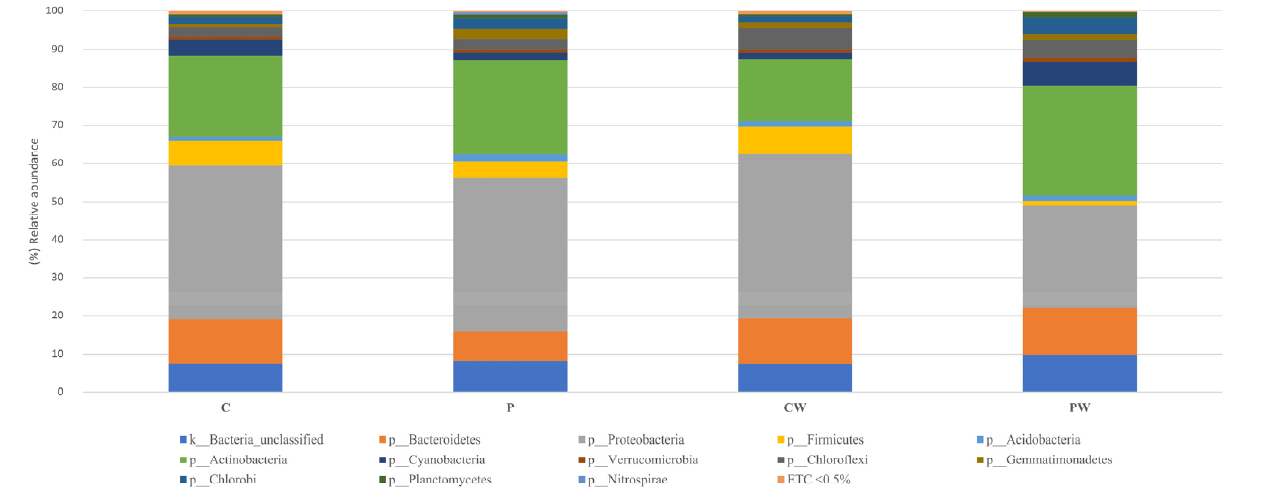
Figure 2. Relative abundance (%) of bacteria at the phylum in the skin mucus microbiota of fish feed with control diet without (C) and with wound (CW); fish feed with probiotic diet without (P) and with wound (PW). ETC: relative abundance <0.5% in average.